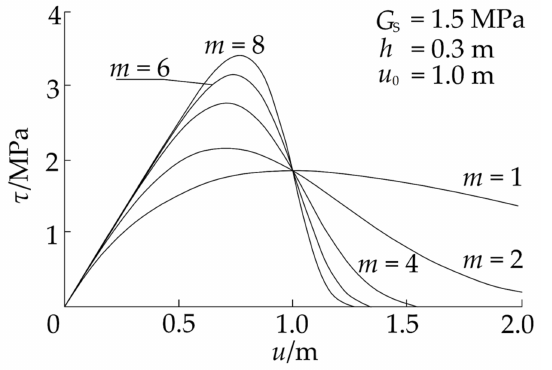
Figure 3. Constitutive curves of sliding zone soil for different values of m